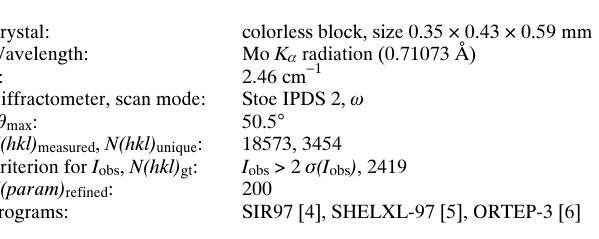
Table 1. Data collection and handling.